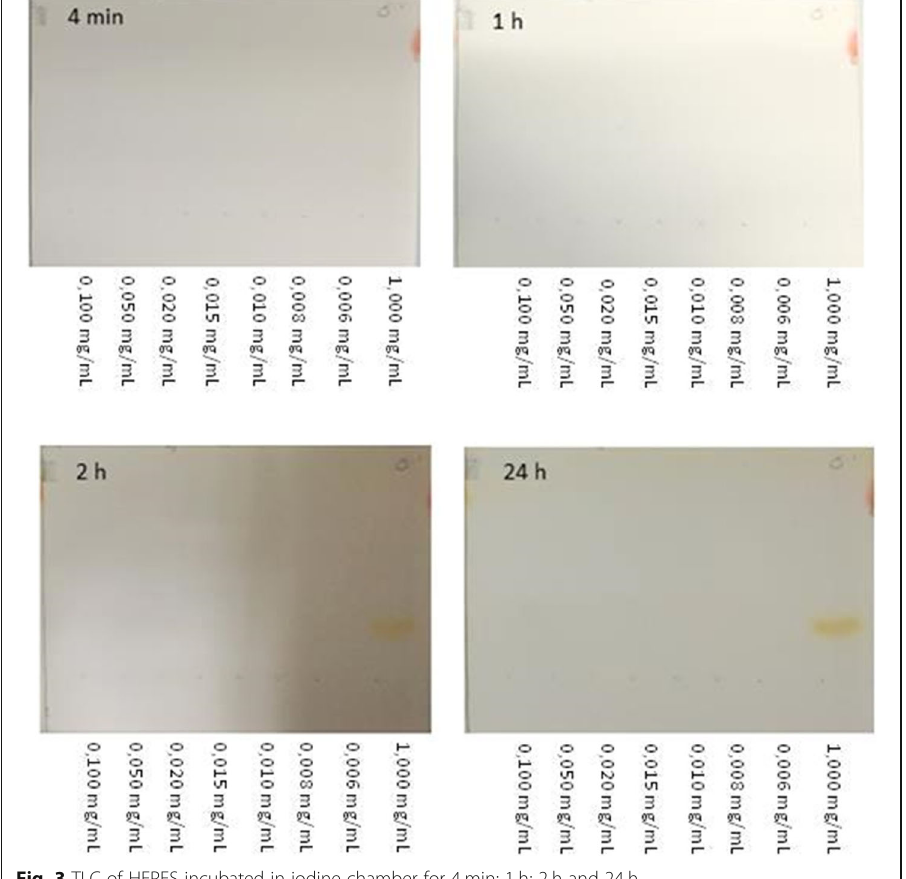
Fig. 3 TLC of HEPES incubated in iodine chamber for 4 min; 1 h; 2 h and 24